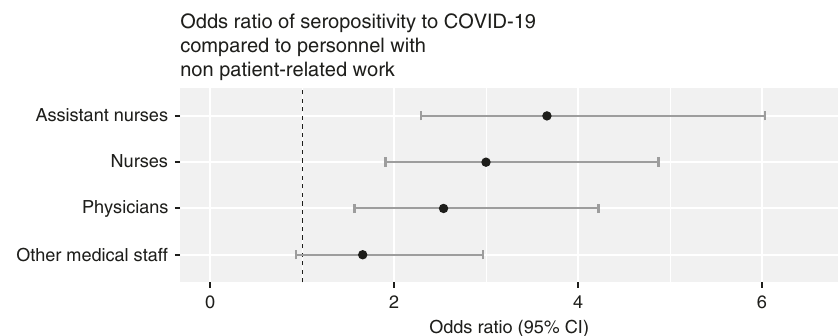
Fig. 4 Associations between occupations and seroprevalence of SARS-CoV 2 IgG antibodies among HCW with patient contact. Odds ratios of seropositivity for groups of HCW with patient contact, compared to personnel without patient contact. Odds ratios were calculated using two-sided Fisher ’ s exact test with n = 733 (assistant nurses vs no patient contact), n = 941 (nurses vs no patient contact), n = 744 (physicians vs no patient contact), and n = 559 (other medical staff vs no patient contact) independent plasma samples. No adjustment for multiple comparisons was applied. Data are presented as odds ratios and 95% con fi dence intervals. Source data are available as Source Data fi le.